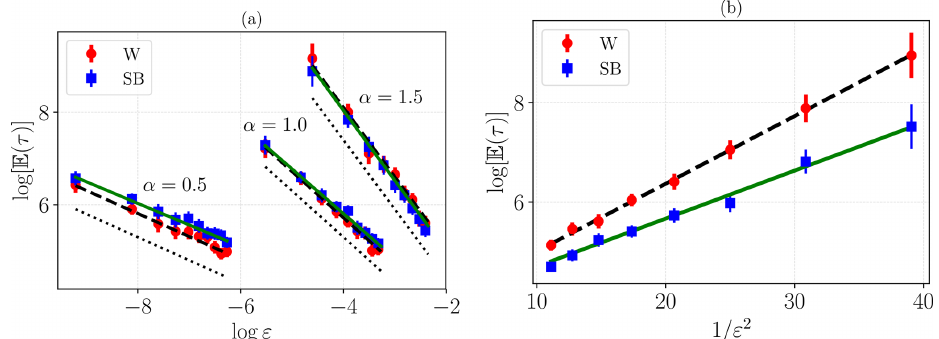
Figure 3. Estimates of the mean escape time E (τ) (in years) from the W (blue circles) and SB (red squares) states, as a function of the noise intensity ε . (a) Lévy noise for α = 0 . 5, 1.0, and 1.5, with the dotted line being the corresponding prediction from Eq. (B6), while the straight green (SB) and dashed black (W) lines are the fittings of Eq. (B6) of the relevant dataset. (b) Gaussian noise, with straight green (SB) and dashed black (W) lines being the fit of Eq. (17), is shown.